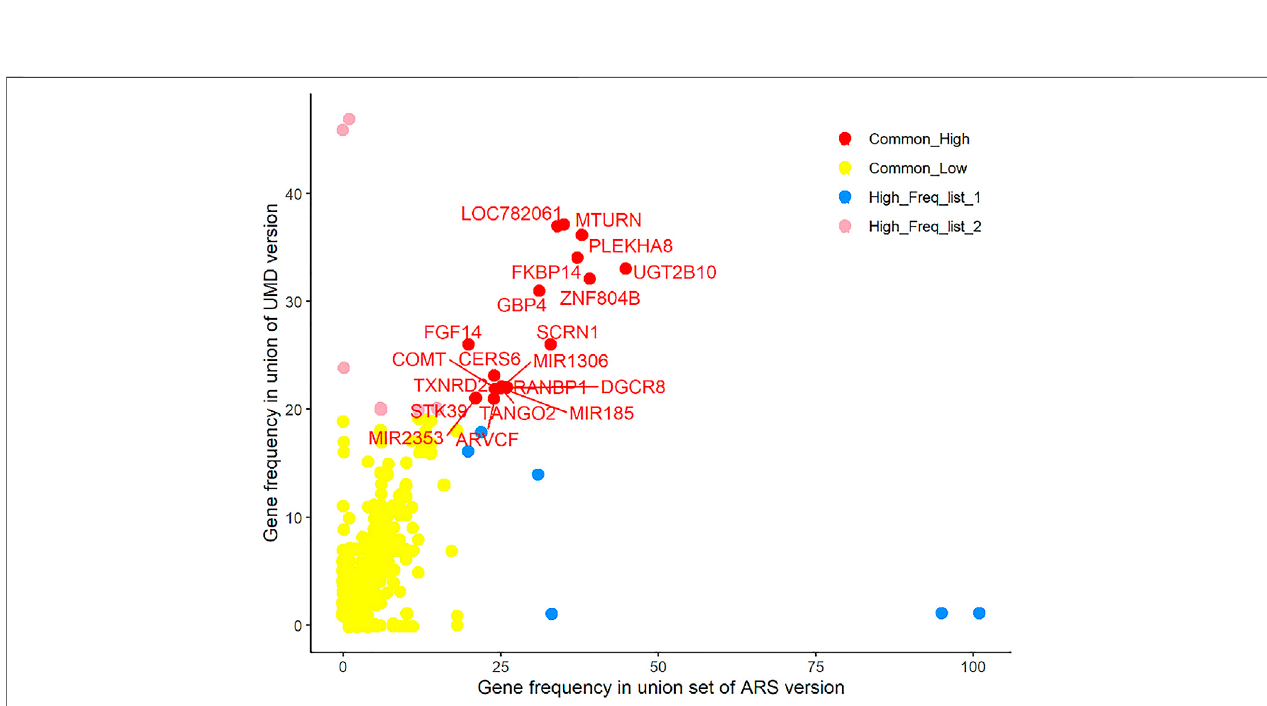
FIGURE 8 | Consensus genes among different results. There are 20 genes in red color that are shown at high frequency in both the ARS and UMD results.